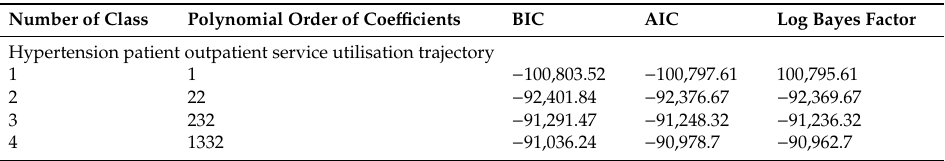
Table 2. Result of model fit statistics.